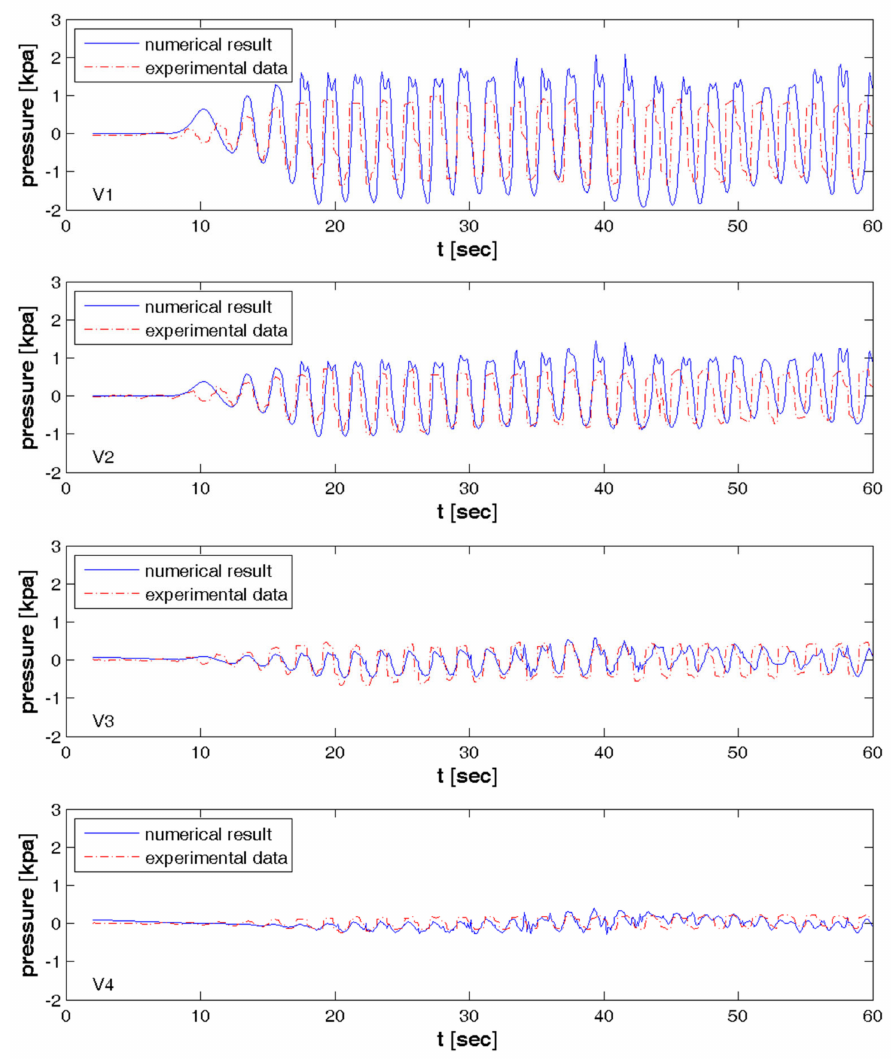
Figure 4. Comparisons of the dynamic wave pressure on the bottom of the caisson breakwater in the typhoon wave condition (H = 0.25 m, T = 2 s) between numerical results (dashed line) and experimental data (solid